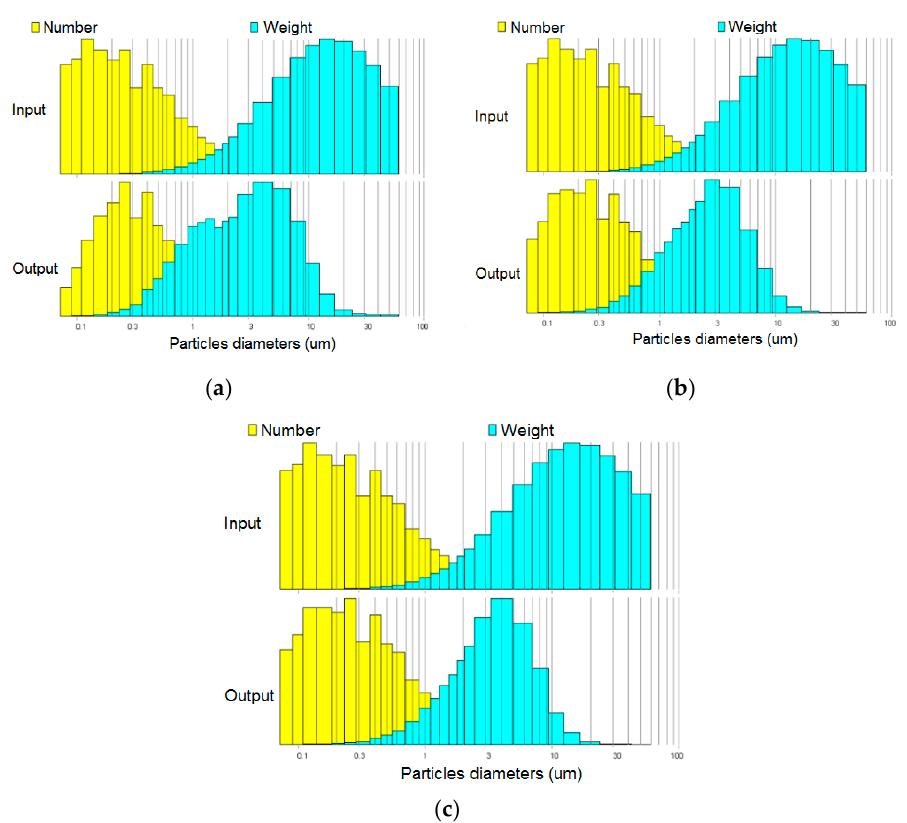
Figure 9. When a full ‐ wave rectified voltage is applied, the number and mass distribution of dust particles at the input and output, as well as the resistivity of dust: ( a ). 10 11 Ω × cm; ( b ). 10 12 Ω × cm; ( c ). 10 13 Ω × cm.